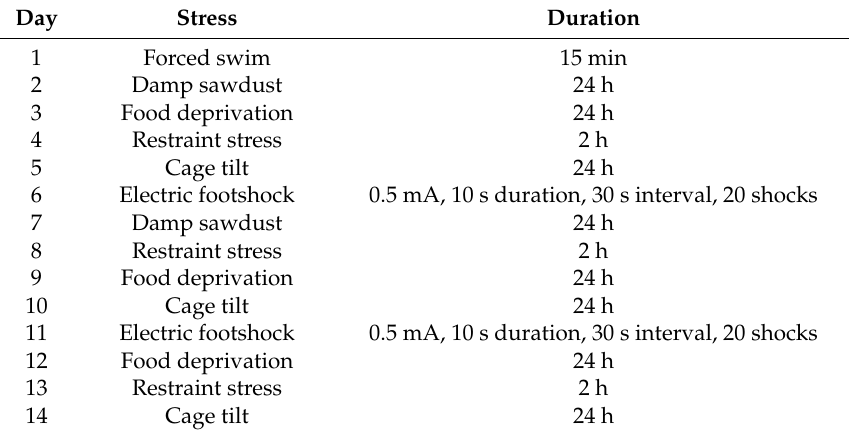
Table 1. Chronic unpredictable stress